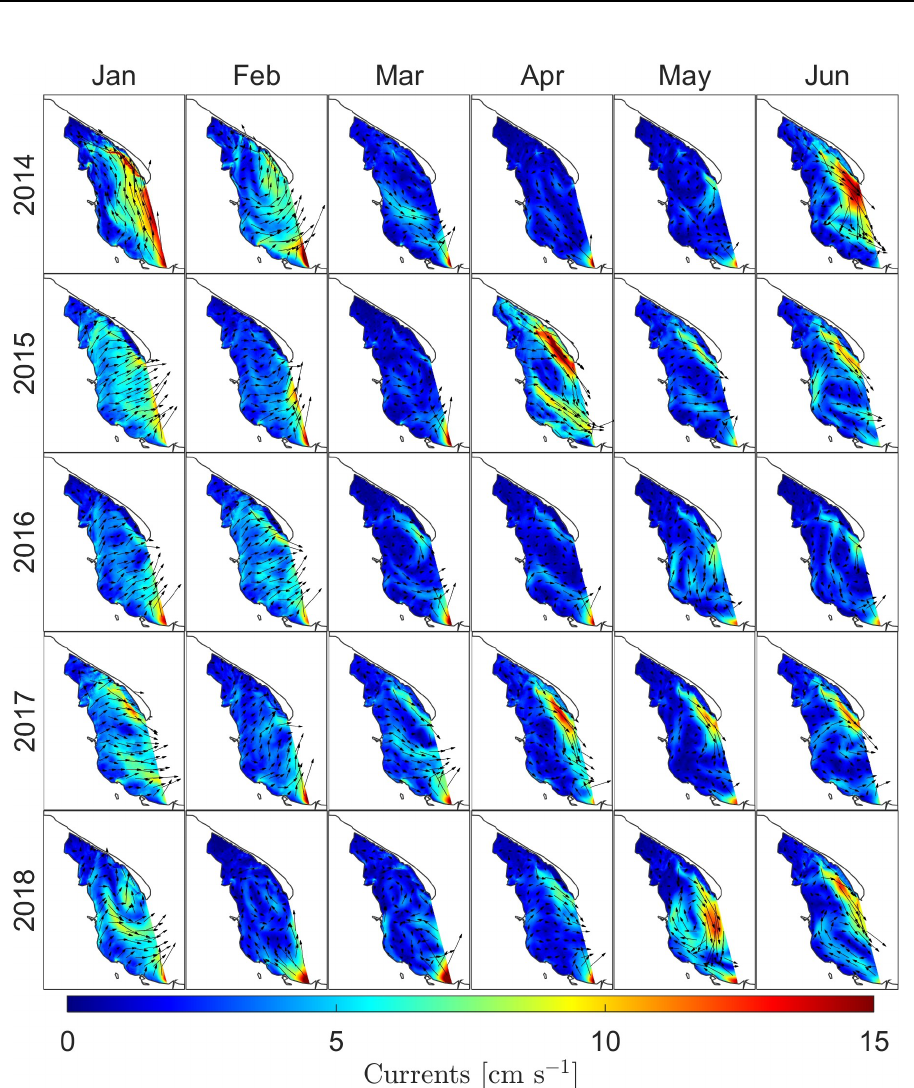
Figure A21. Monthly means of currents at surface level for separated years. January to